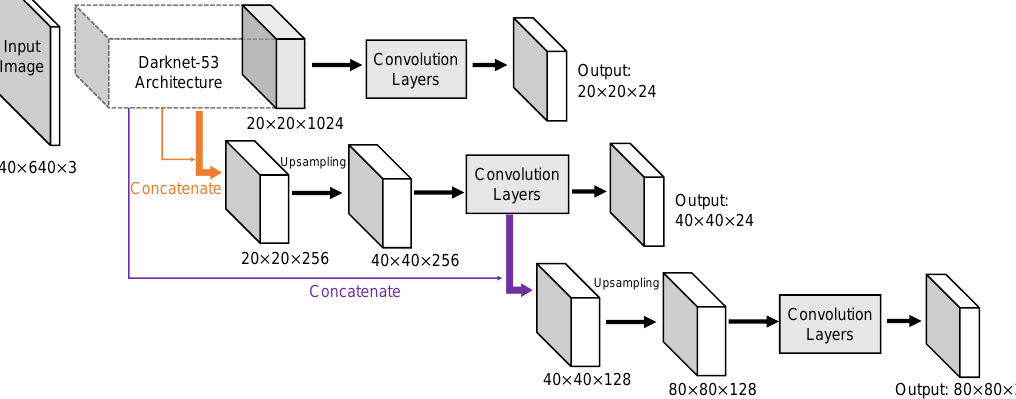
Figure 5. Architecture of YOLOv3 model. Pyramid network leads to a greater output but also helps to extract more potential features. With anchors set to 9, each layer had 3 anchors sort descending.